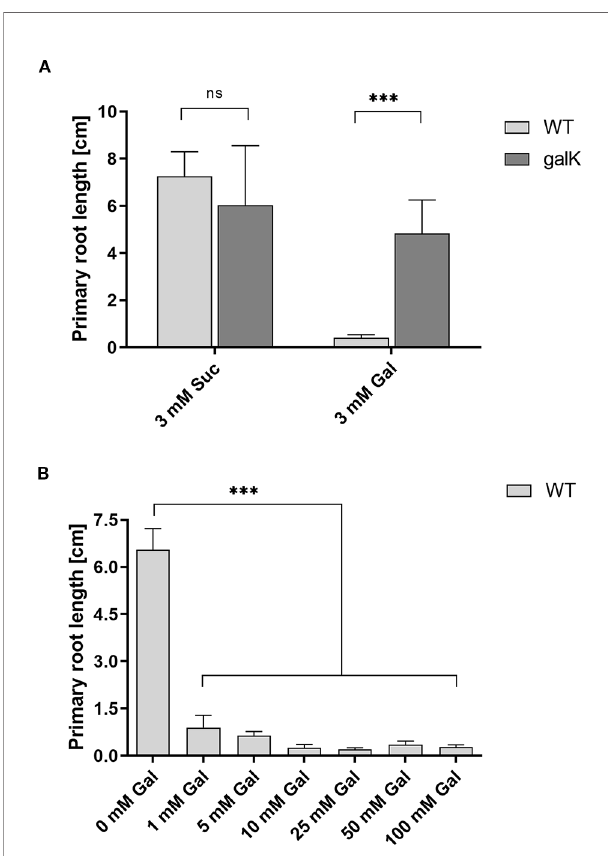
FIGURE 2 | Root length reduction of WT seedlings on agar plates with galactose. (A) Primary root length of two weeks old WT seedlings compared to galK seedlings on 0.5× MS plates with either 3 mM sucrose or 3 mM galactose. (B) Root length of 11 d old WT seedlings growing on increasing galactose concentrations. Values are averages (± SD) of the measurement of six plants using the ImageJ software. Data analysis was performed using one- way Anova and Tukeys multiple comparison test (A) or Dunnett ’ s multiple comparisons test (B) ; ns, non signi fi cant; ***, p